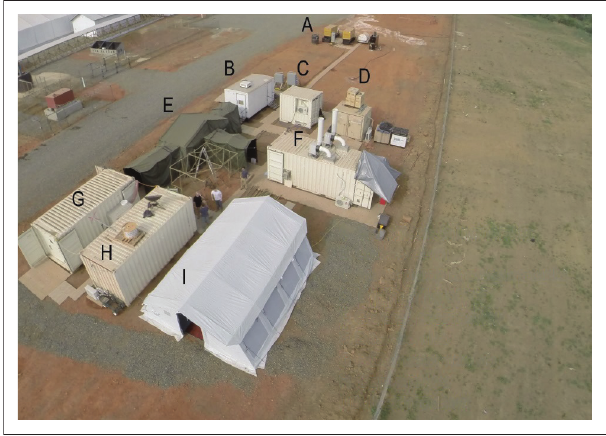
FIGURE 3: Worksite layout for the MRIGlobal mobile diagnostic laboratory, Moyamba, Sierra Leone. Each laboratory unit is labelled appropriately.